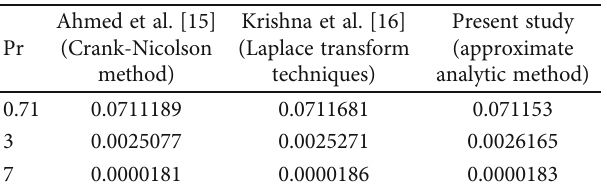
Table 4: Comparison of results of temperature, t = 1 , Ec = 0 : 3 , F = 0 : 5 , H = 1 , and y = 2 .